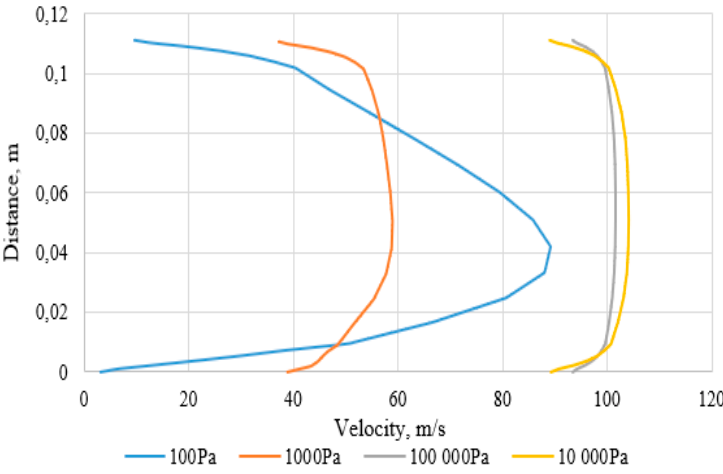
Figure 11. Velocity profiles of the cooling air in the duct above the batteries.